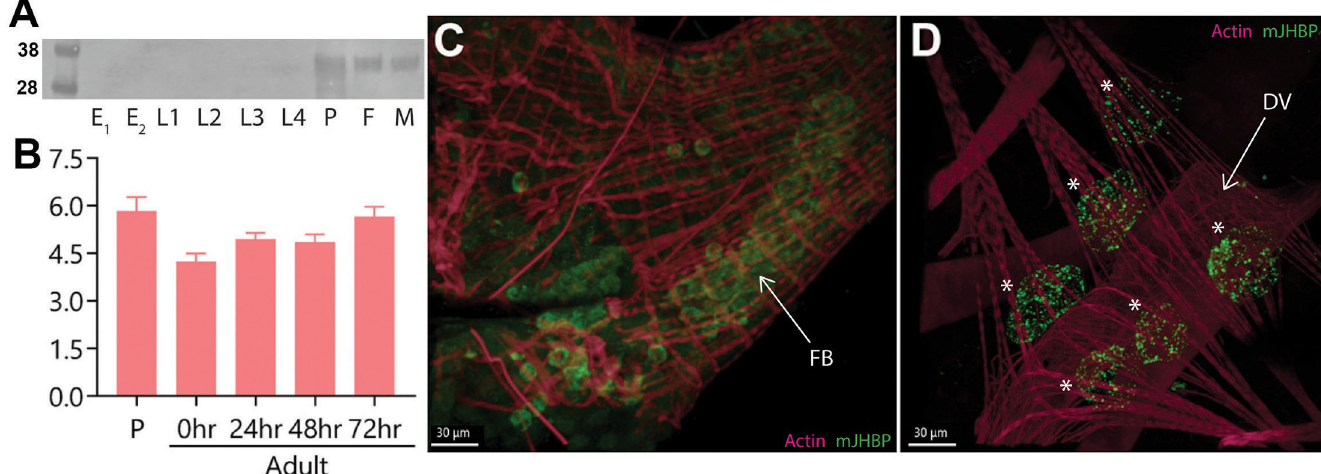
Fig 1. Expression, quantification and detection of mJHBP in Ae . aegypti . A. Detection of mJHBP protein in developmental stages by SDS-PAGE (NuPage) and Western blotting of whole mosquito homogenates (protein standard sizes in kilodaltons are shown on left). E1: Embryo (n = 20), E2: Egg (n = 20), L1: 1 st instar larvae (n = 20), L2: 2 nd instar larvae (n = 20), L3: 3 rd instar larvae (n = 20), L4: 4 th instar larvae (n = 20), P: pupae (n = 5), F: adult female (n = 5), M: adult male (n = 5). Samples were reduced with NuPAGE sample reducing agent (stabilized dithiothreitol) prior to electrophoresis. Molecular size standards are shown to the left of the gel. B. Quantitation of Ae . aegypti mJHBP protein in individual pupae (P) and adult female mosquitoes (0, 24, 48 and 72 h post emergence) measured by ELISA. Each bar represents the mean (ng / individual ± SEM) quantity of mJHBP from 15 mosquitoes (3 replicates of 5 insects in each experiment). There are no statistical differences between timepoints or developmental stages. C. Visualization of Ae . aegypti mJHBP protein in the fat body (FB) by confocal microscopy. mJHBP, green; actin, magenta. D. Visualization of Ae . aegypti mJHBP protein in pericardial cells (asterisks, DV = dorsal vessel) by confocal microscopy. mJHBP, green; actin, magenta; Scale bar, 30 μ m.